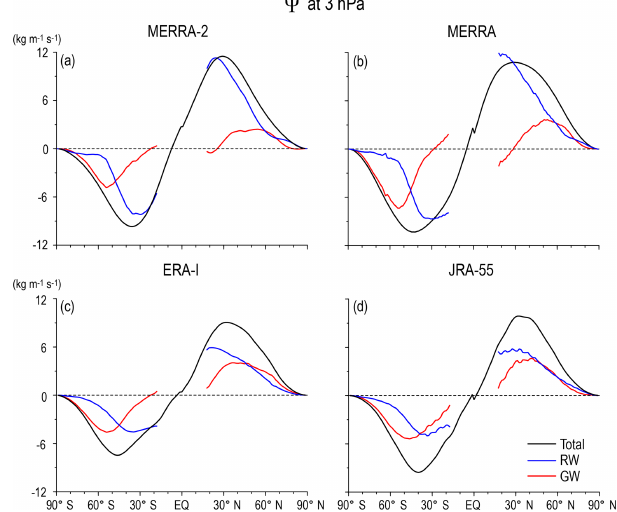
Figure 3. Latitudinal profiles of the climatology of the annual mean stream function of the residual mean flow (black), and contribu- tions of RWs (blue) and GWs (red) at 70hPa for (a) MERRA-2, (b) MERRA, (c) ERA-Interim, and (d) JRA-55.